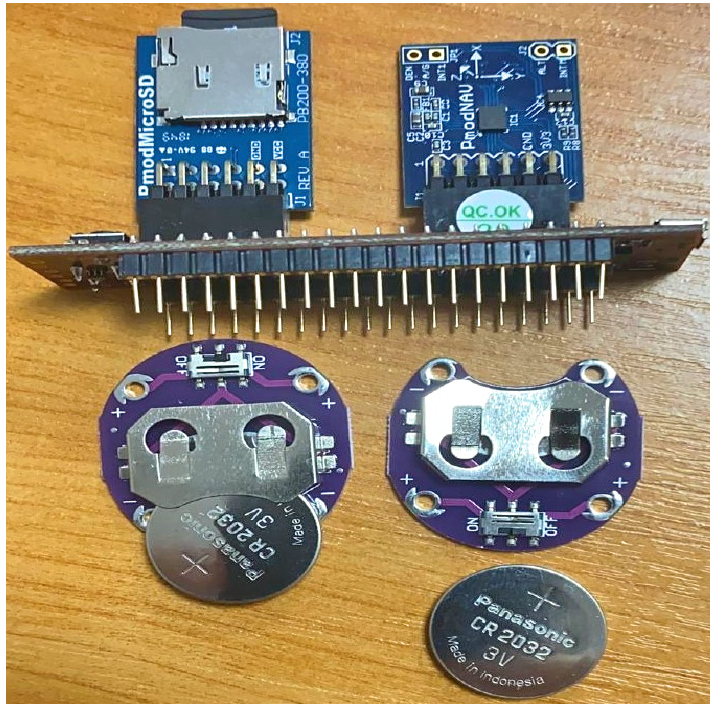
Figure 2. Components used for development of the AWEAR bracelet.